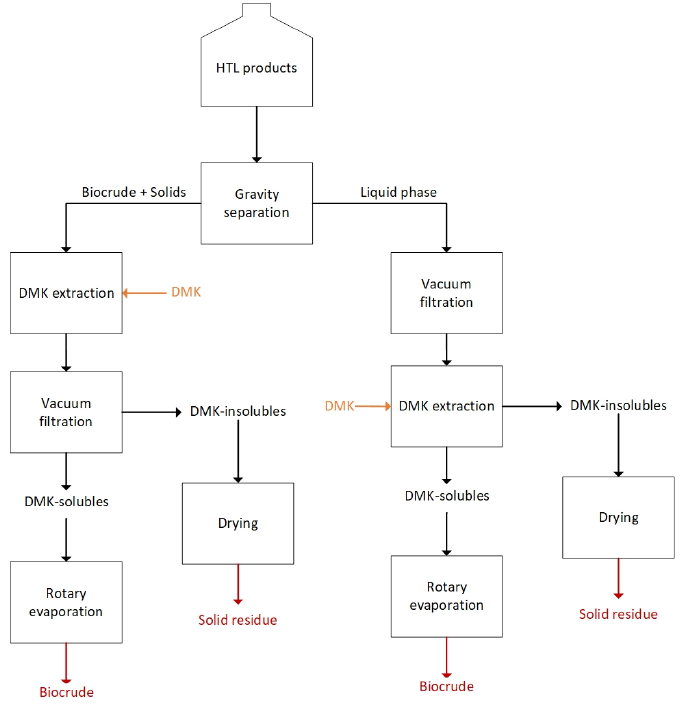
Figure 2. Extraction procedure for HTL products recovery.